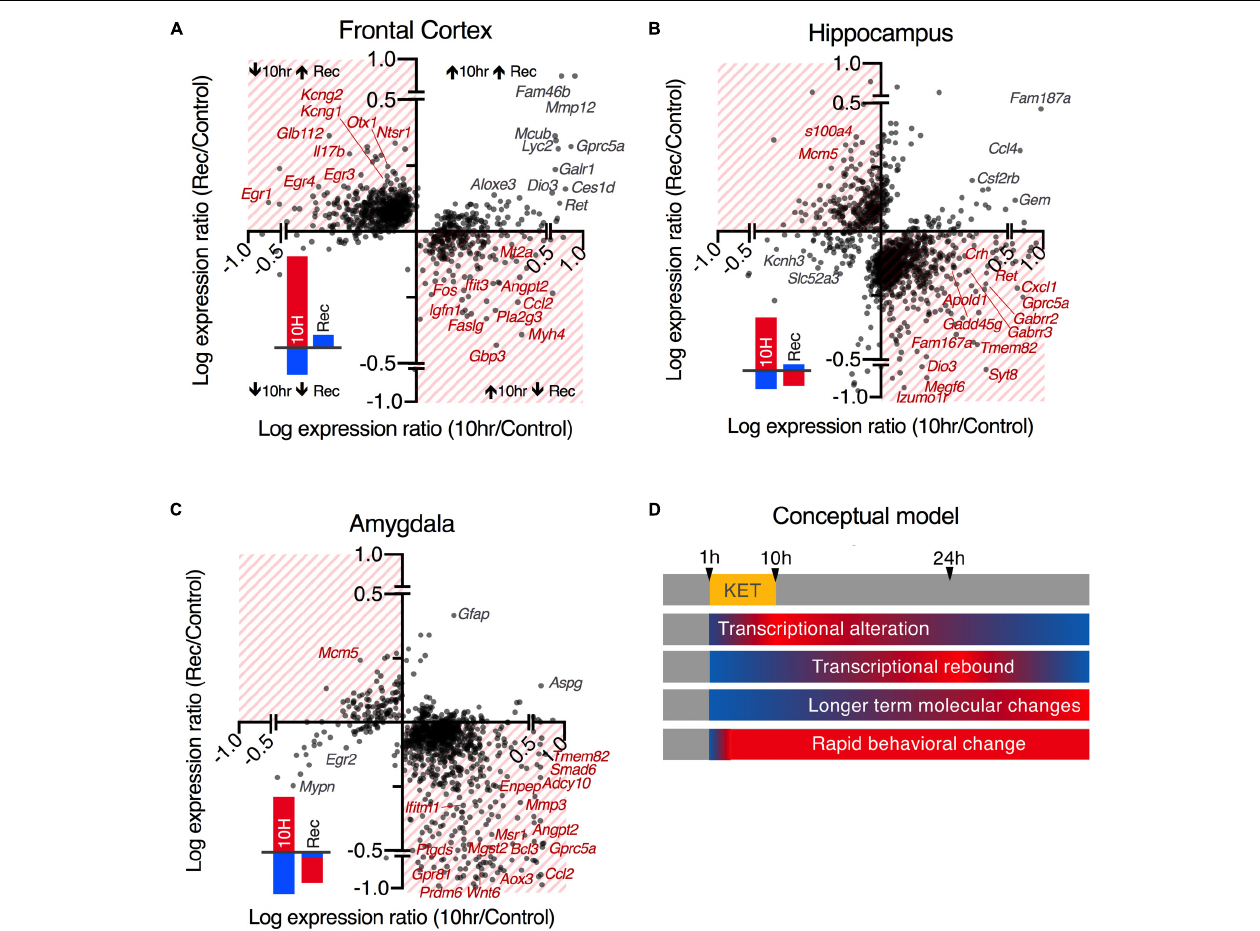
FIGURE 3 | Comparison of 10 and 24 h recovery gene changes. (A–C) Expression ratios are compared between the 10 h/control data and the recovery/control. Log-transformed expression ratios of 10 h vs. control (x-axis) and recovery vs. control (y-axis) are shown for all DEGs by brain region. Genes that show rebound transcriptional changes opposite to the direction of regulation at 10 h are highlighted in hatched quadrants (quantified in the red and blue bar graphs in lower left quadrants). Example genes with the highest levels of discordant regulation at 10 h and Rec are labeled in red. Genes with the highest levels of concordant regulation (do not return to baseline) are in the clear quadrants and are labelled in gray. Note that there appears to be a tendency toward increased numbers of genes in the hatched quadrants generally, and that there is more tendency for the genes to move in the opposite direction in the recovery among genes decreasing in the frontal lobe (A) or increasing in the hippocampus (B) or amygdala (C) . (D) A conceptual model is shown for the temporal dynamics of the observed transcriptional events. Transcriptional events, which are the primary endpoints of RNA-Seq, have known temporal dynamics with a T 1 / 2 of mRNA estimated at ∼ 2.5–3 h (Singer and Penman, 1972). The 10 h time point was selected because it is about 4 half-lives, implying near total turnover. Return to transcriptional homeostasis after withdrawal of the drug does not necessarily coincide with the end of the ketamine-induced process, as translational processes, protein level, post-translational modifications, network-level, and behavioral alterations may persist. The observations at the 24 h time point also suggest a tendency toward transcriptional overshoot or “rebound” rather than return to homeostasis.